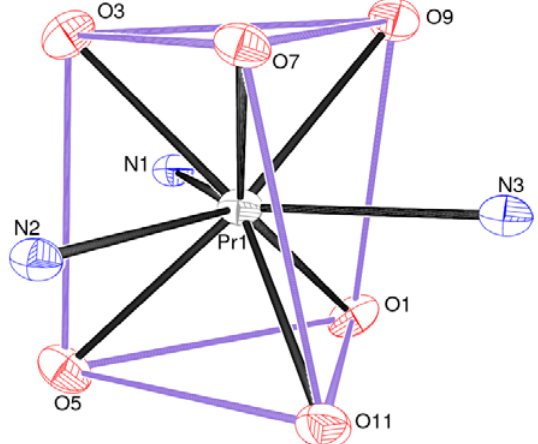
Figure 2. Detail of 1 showing the tri-capped trigonal prismatic coordination of Pr1 (50% displacement ellipsoids). The orchid-colored lines indicate the trigonal prism of O